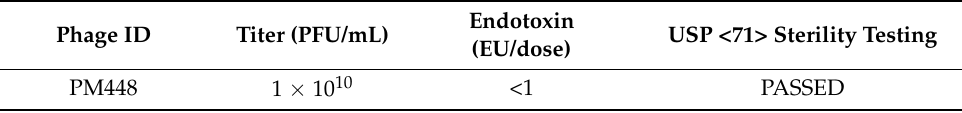
Endotoxin USP <71> Sterility Testing (EU/dose)